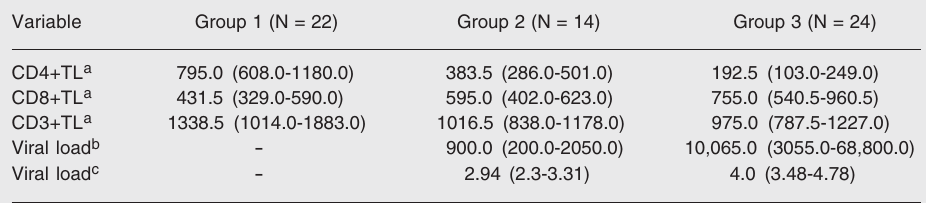
Table 2. CD4+ T lymphocyte (TL), CD8+TL and CD3+TL counts and HIV load in peripheral blood.